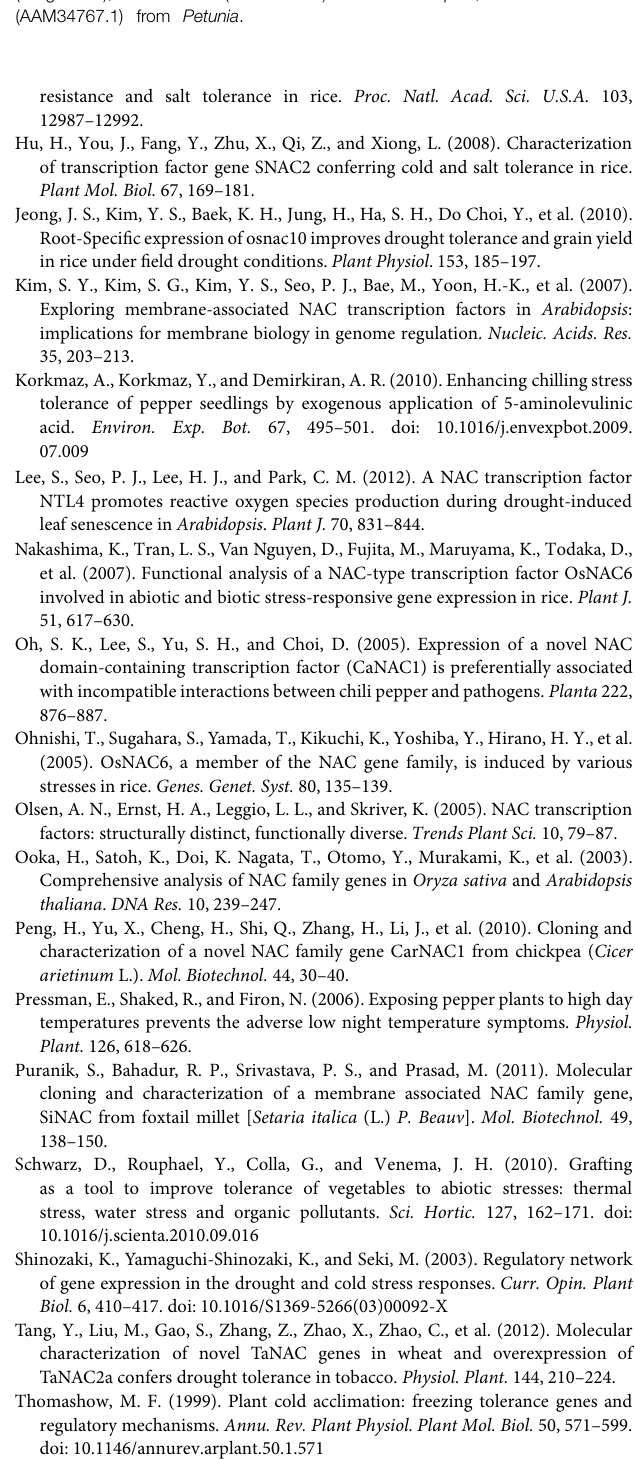
FIGURE S2 | Amino acid sequences alignment of pepper CaNAC2 with others. The five conserved motifs (A to E) are shown by thin underlines. The rich Ser regions in the C-terminal part are shown by thick underlines. The nuclear localization signal is lined with double arrows. The genes included are ANAC050 (XP_002882675.1), ANAC051/52 (XP_002882676.1), ANAC053 (NP_566376.1), ANAC078 (At5g04410), and NAC2 (AAF09254.1) from Arabidopsis , NH4 (AAM34767.1) from Petunia